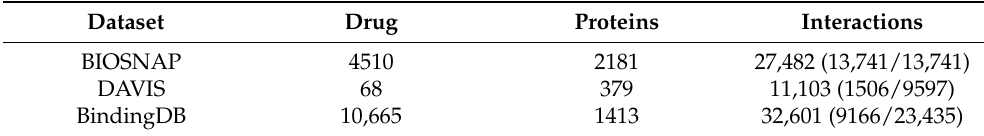
Table 1. Dataset